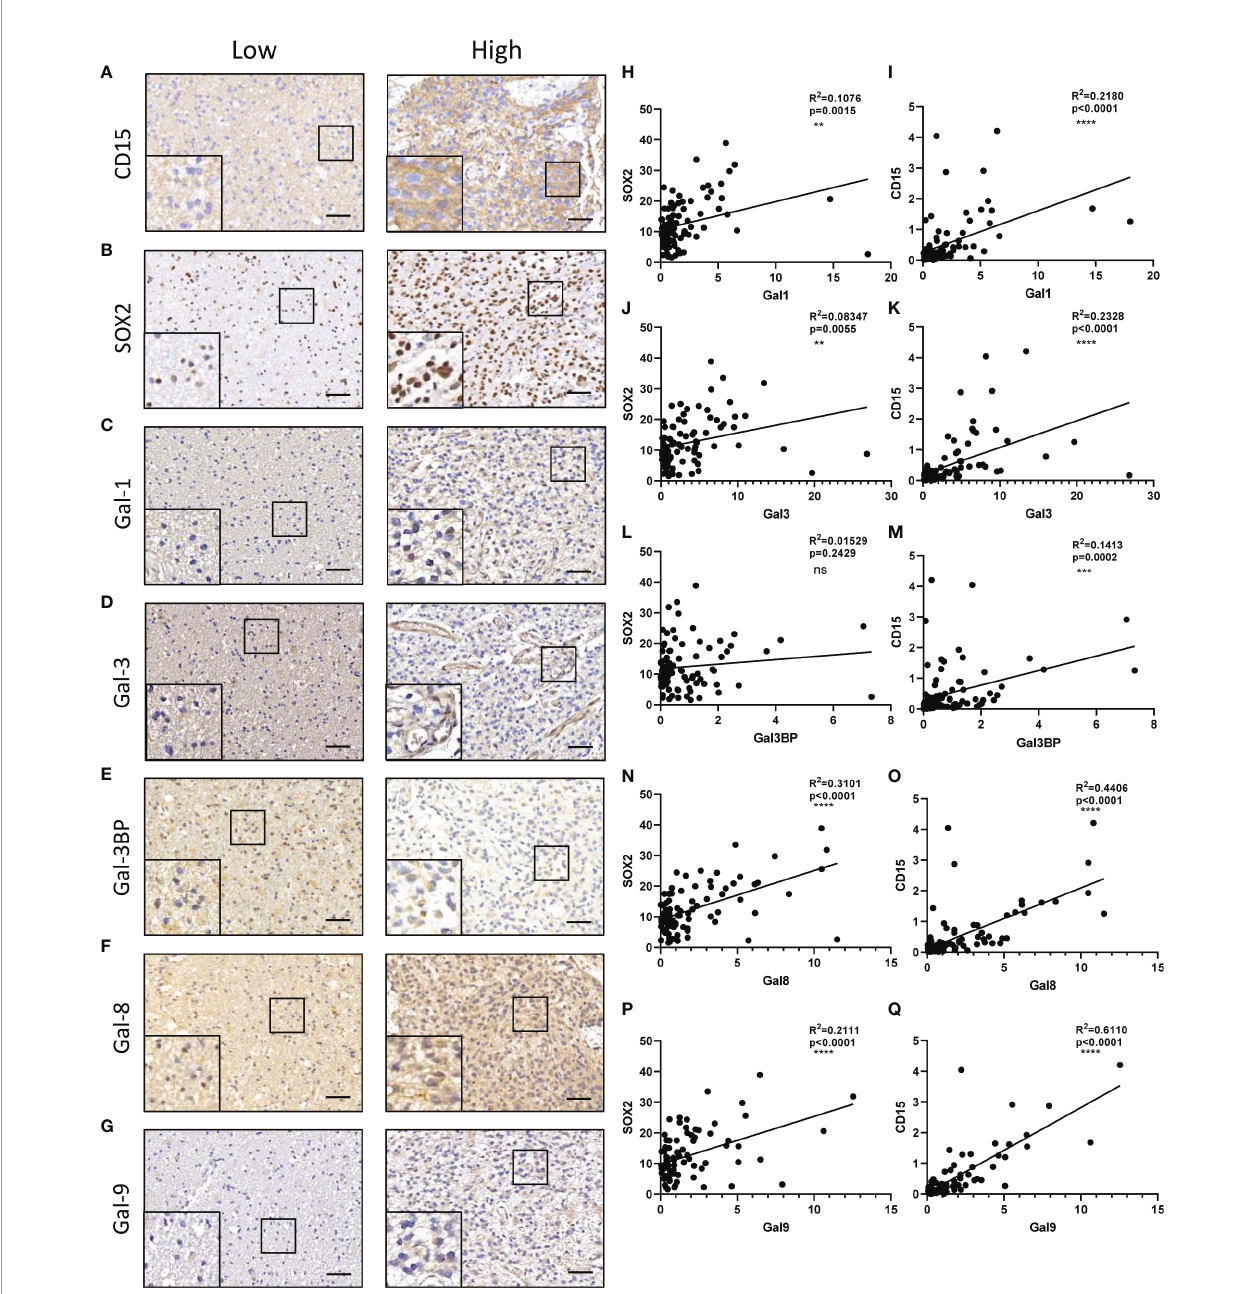
FIGURE 9 | Correlations between galectins and GSC content at the protein level in glioma tissues. CD15 (A) , SOX2 (marker for GSCs) (B) , Gal-1 (C) , Gal-3 (D) , Gal-3BP (E) , Gal-8 (F) , and Gal-9 (G) are shown. The scale bar measures 40 m m. (H, J, L, N, P) Pearson correlation analysis of the positive stain ratio of SOX2 and Galectins. (I, K, M, O, Q) Pearson correlation analysis of the positive stain ratio of CD15 and Galectins. GSC, glioma stem cell **p<0.01, ***p<0.001, ****p<0.0001, ns, No signi fi